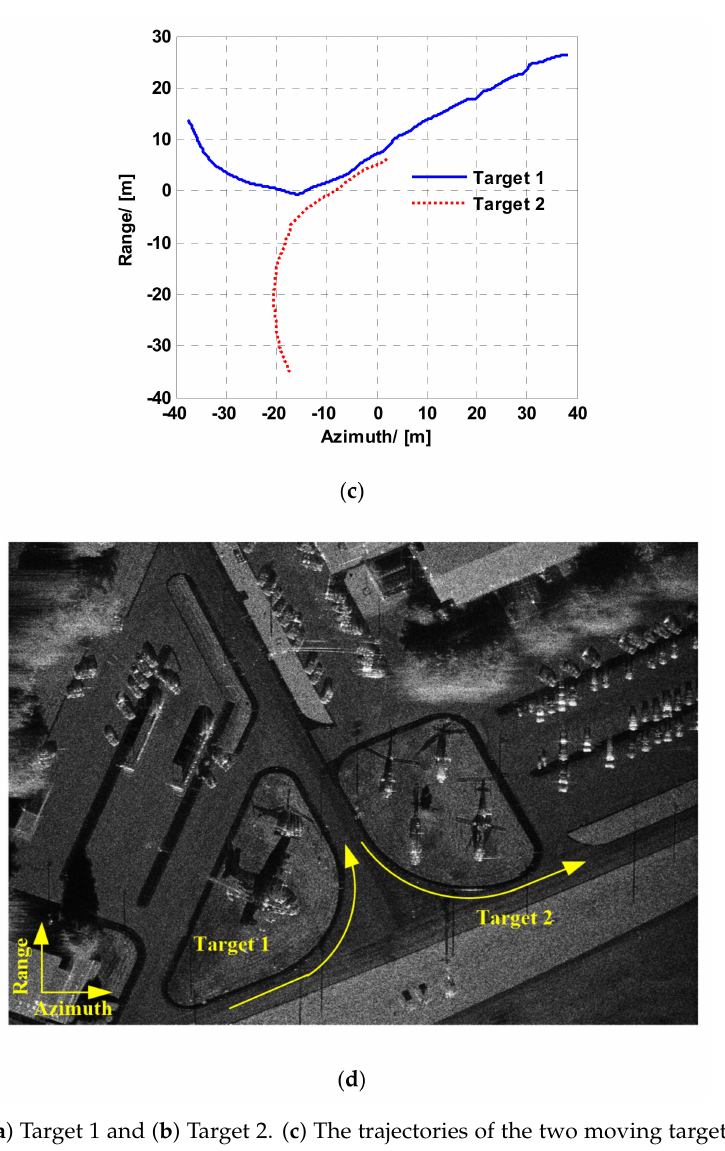
Figure 19. Velocities of ( a ) Target 1 and ( b ) Target 2. ( c ) The trajectories of the two moving targets. ( d ) The overview of the simulation.